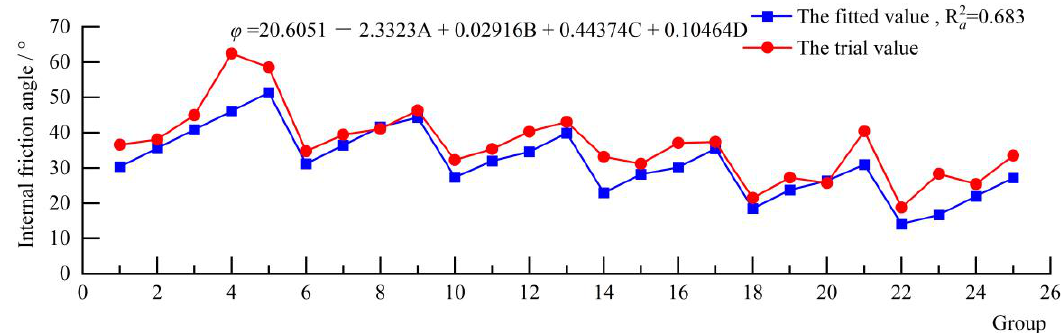
Figure 8. Comparison of fitted and experimental results for internal friction